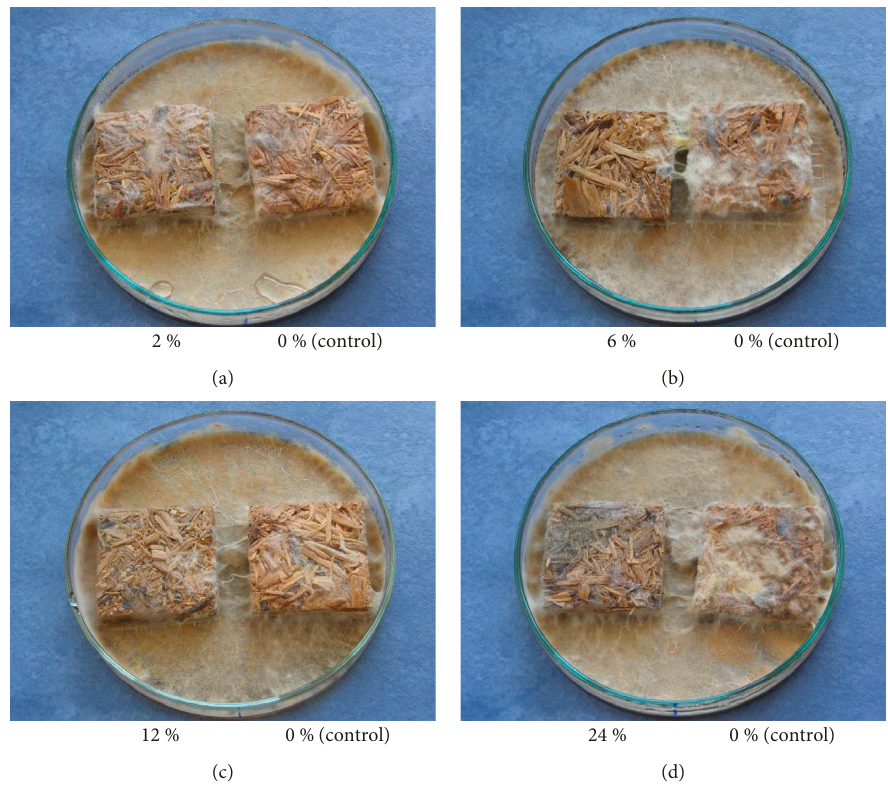
Figure 2: Growth of the surface mycelia of the brown-rot fungus Coniophora puteana on the top surfaces of the nano-ZnO-treated PBs (prepared by MUF glues modified by addition of 2, 6, 12, or 24% wt. ZnO) and the control PB, after 6 weeks of the decay test.